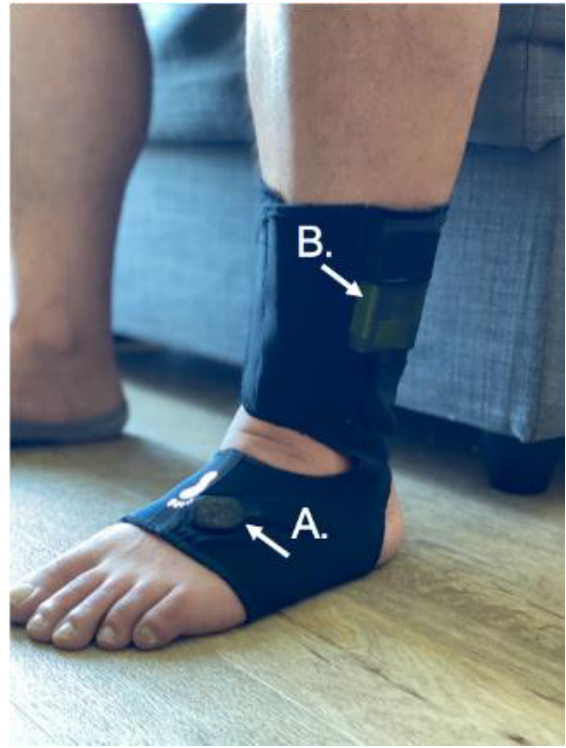
Figure 1. Participant wearing an instrumented sock, APDM prototype. The inertial sensor is located on top of the foot ( A ), and the main unit containing the battery in the socks is located in a second pocket just above the lateral malleolus ( B ). To maximize fit, the socks come in different sizes, and the Velcro attachment around the foot and ankle is adjustable to ensure a snug fit and that the sensor does not move on the foot while being worn.